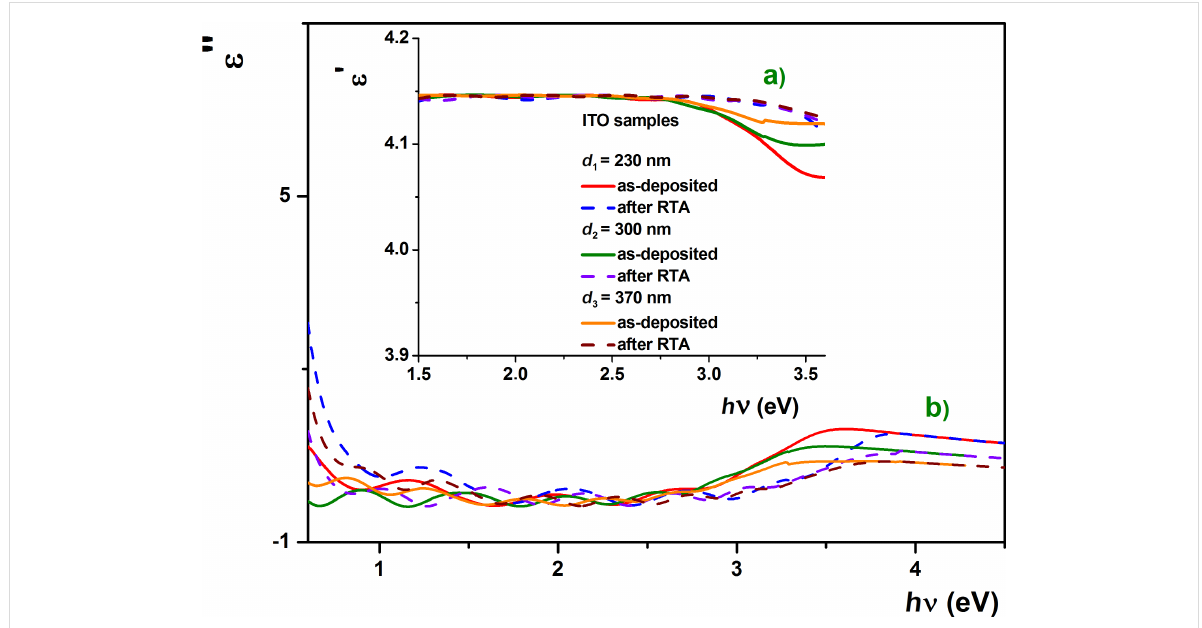
Figure 9: Photon energy dependence of the a) real and b) imaginary part of the complex dielectric permittivity for the as-deposited and RTA-treated ITO samples.